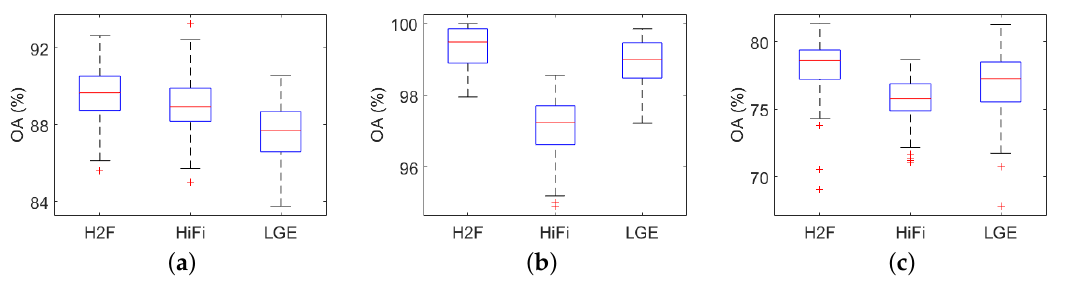
Figure 7. Box plots of different methods on ( a ) Indian Pines; ( b ) KSC and ( c ) GRSS_DFC_2014 data sets.